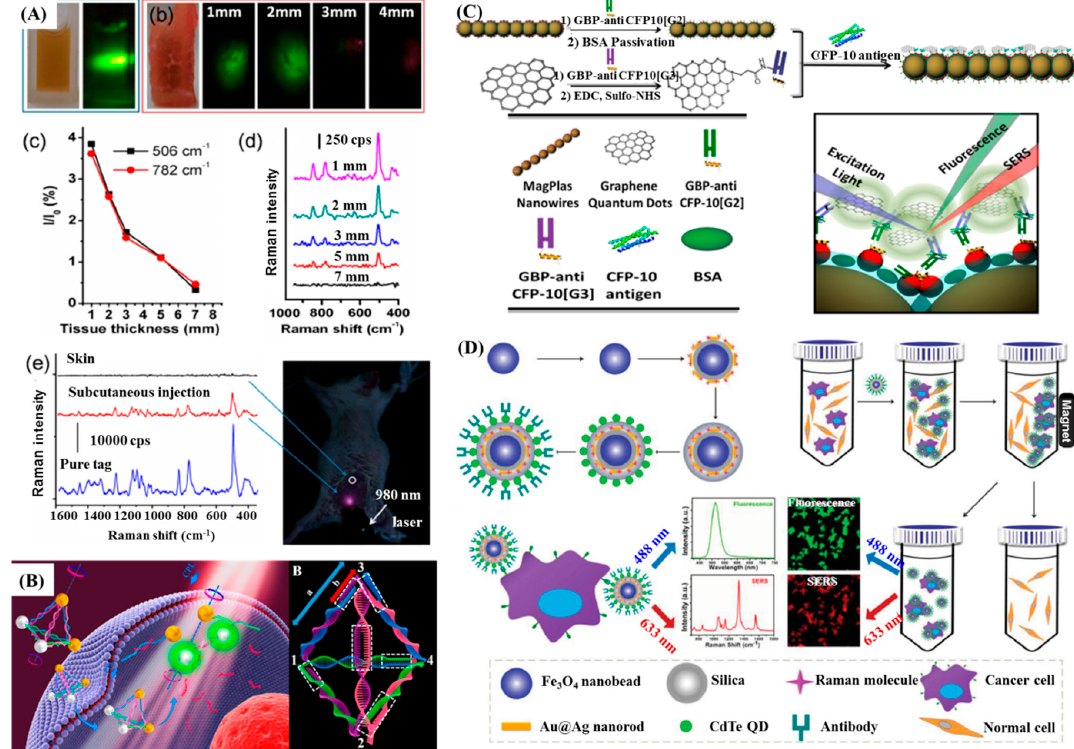
Figure 7. ( A ) Bioimaging applications of UCF-SERS tags. Reproduced with permission from reference [121]. ( B ) Working principle of Au-UCNP pyramids for miRNA detection and the nucleic acid skeleton of pyramid used for miRNA detection. Note: 3, 4 are linked with Au NPs; 1, 2 are linked with UCNPs. Part a: Recognition sequence of miRNA; and part b: non-complemented part (circled by white dashed line). Reproduced with permission from reference [24]. ( C ) Schematic representation of the synthesis of CFP-10 antibody (G2 or G3)-functionalized Fe 3 O 4 @PEI@Au nanowires (MagPlas NW) and GQD nanocomposites and (lower right) the detection mechanism of the SERS-induced immunoassay to monitor the target CFP-10 antigen. Reproduced with permission from reference [122]. ( D ) Schematic illustration of the fabrication of the nanoprobe, the process of cancer cells with specific receptor on their surfaces captured by the nanoprobes and the cell separation procedures. Reproduced with